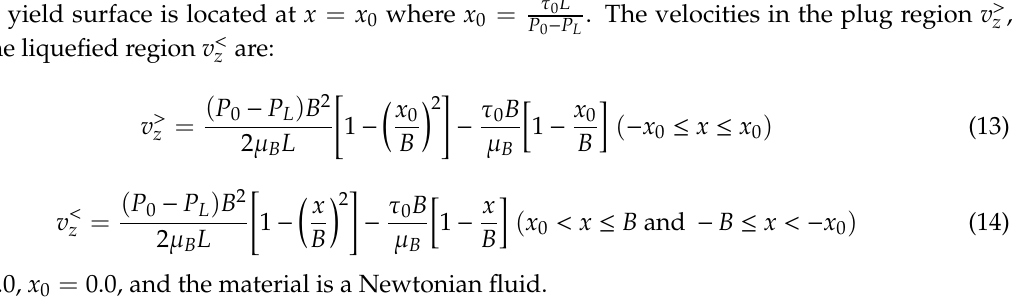
Figure 1. Flow in a channel driven by the pressure gradient, showing the plug region −𝑥 0 ≤ 𝑥 ≤ 𝑥 0 and the liquefied region 𝑥 0 < 𝑥 ≤ 𝐵 and −𝐵 ≤ 𝑥 < −𝑥 0 , based on Byron-Bird [49].